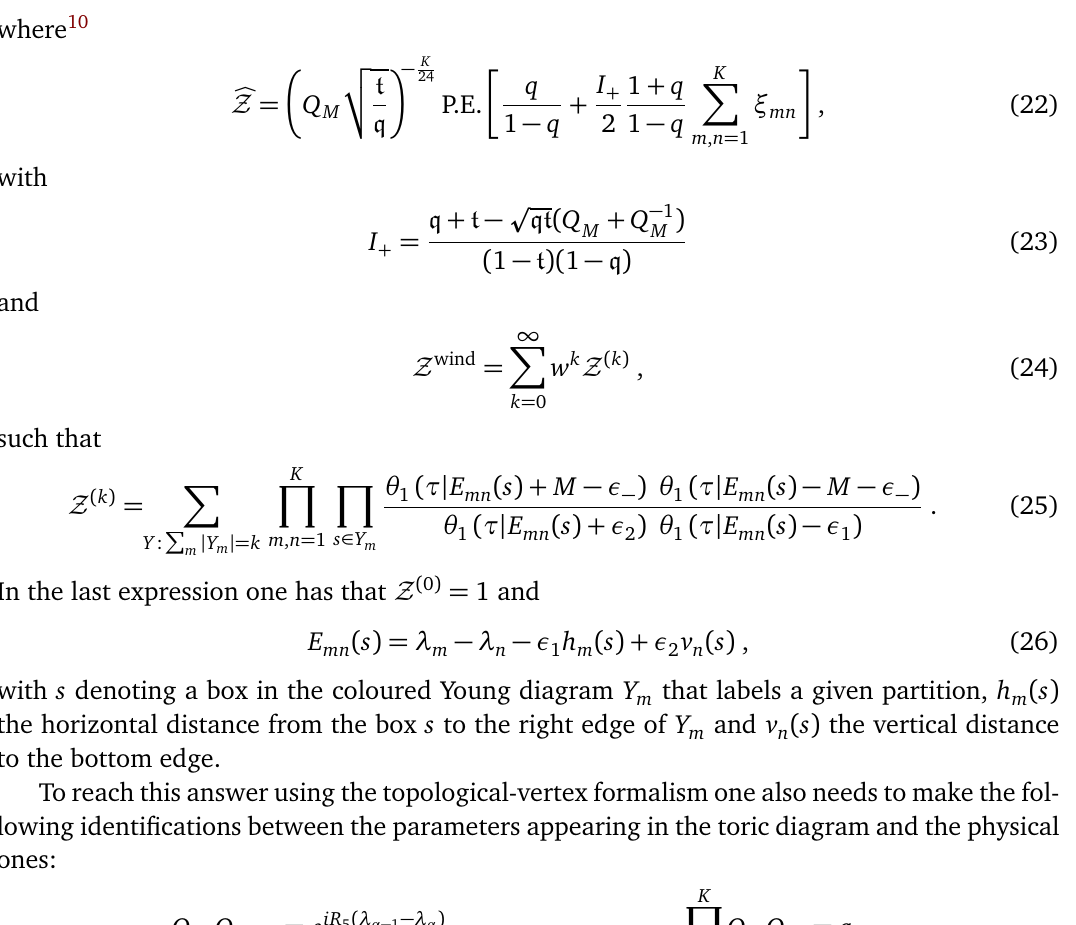
Figure 3: The dual toric diagram for the rank- K LST. The vertical direction has been chosen as the preferred one. There are no non-trivial framing factors. Each internal line is associated with a Kähler parameter and a partition. The periodic identification of both horizontal and vertical lines is indicated by the cyclic identification of Kähler parameters and their associated